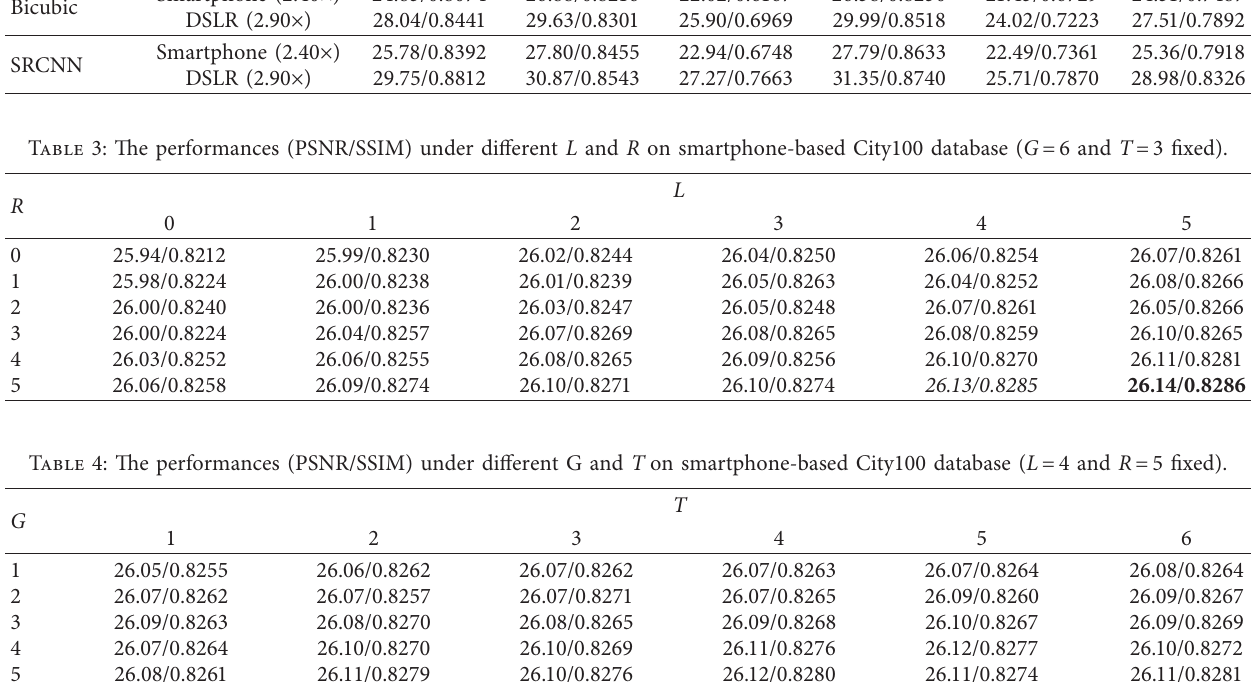
Table 2: The performance benchmarks (PSNR/SSIM) on valid City100. Images Method